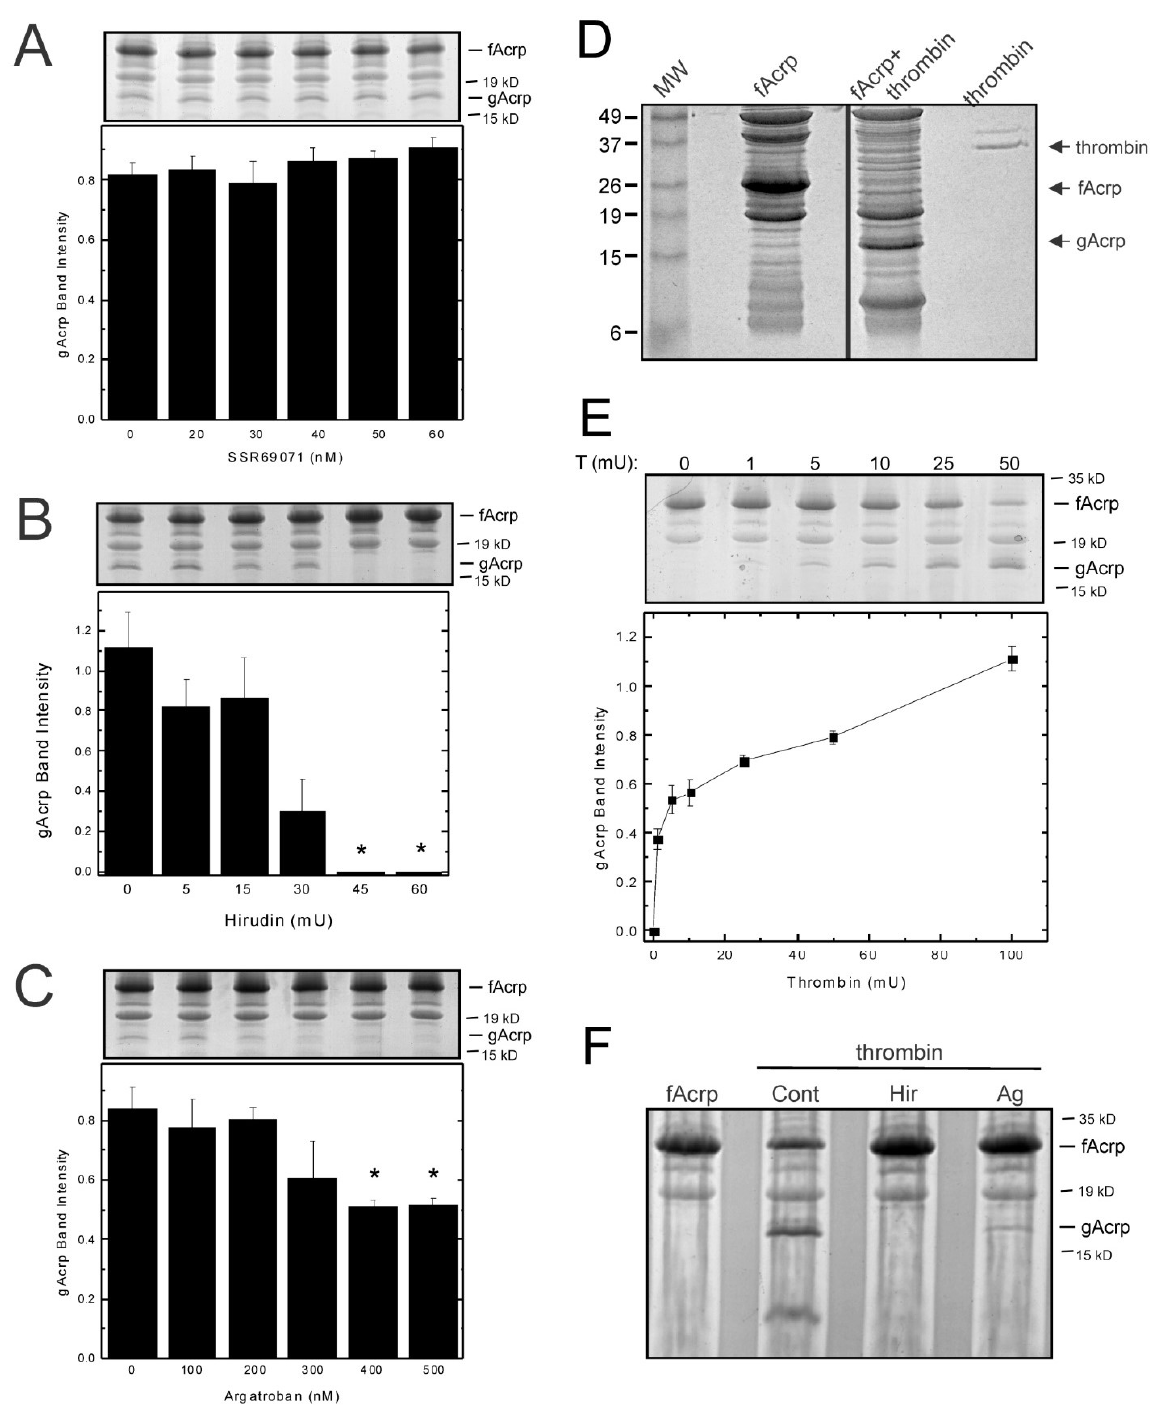
Figure 4. Effect of protease inhibition on cleavage of adiponectin. Cleavage of adiponectin (1 µg) was measured under the standard assay conditions in the presence of varying amounts of ( A ) SSR69071 (leukocyte elastase inhibitor), ( B ) hirudin (thrombin inhibitor) and ( C ) argatroban (thrombin inhibitor). Representative stained gels are provided for each inhibitor. Intensity of the 18 kDa band was quantified by scanning densitometry and the data are plotted as means ± sem ( n =